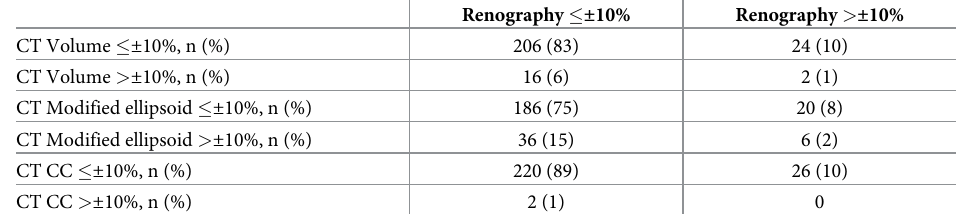
Table 2. Agreement between modalities when difference in split kidney function is greater than/equal to or less than/equal to 10%, n = 248.